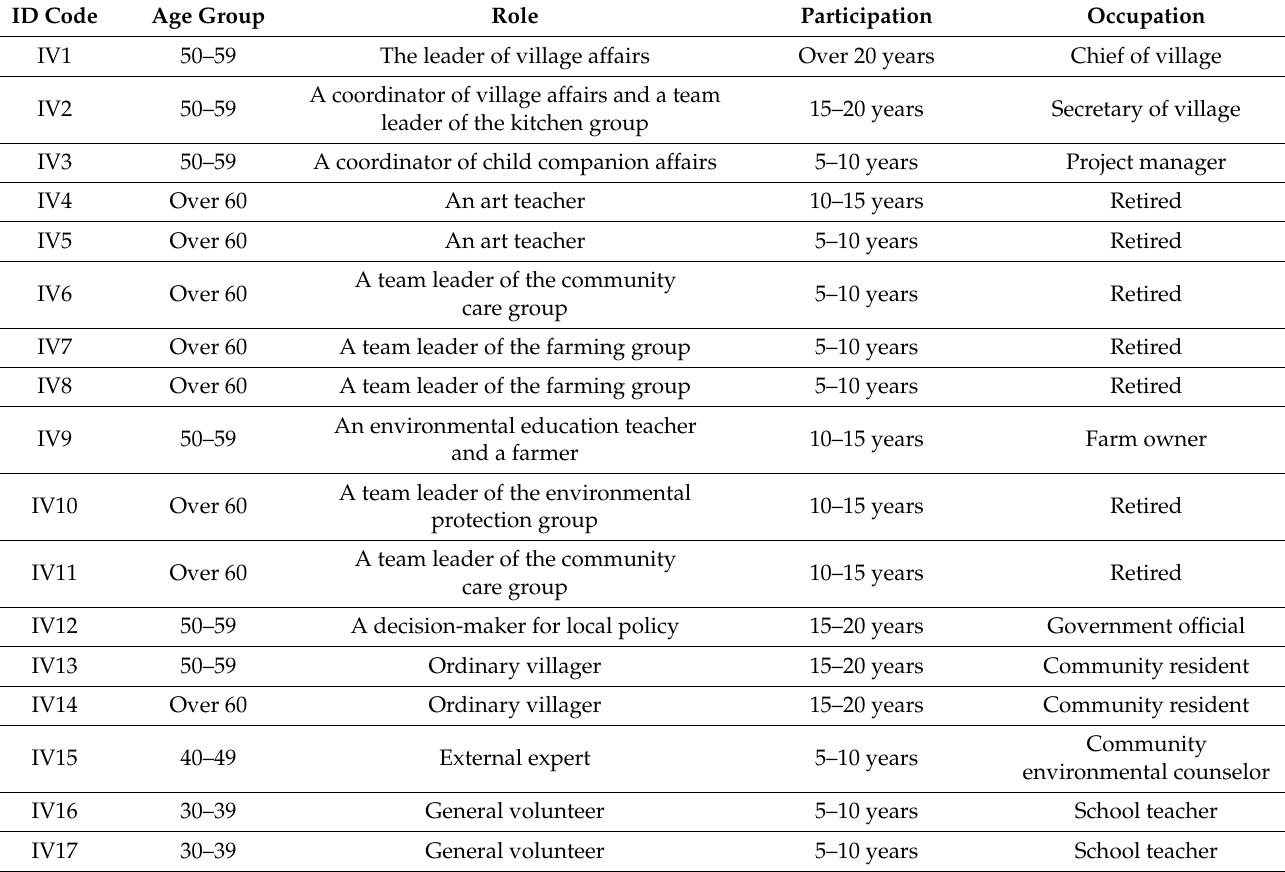
Table 1. Demographic data of the in-depth interview participants.